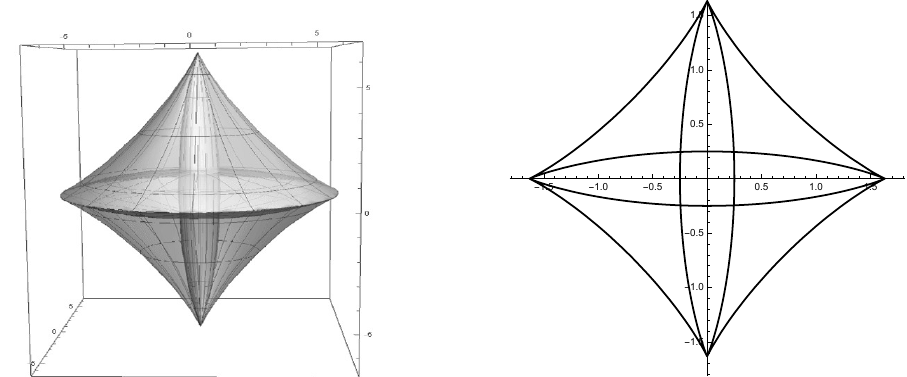
Figure 3. Left : The image ξ γ ( S 2 ) of the Cahn–Hoffman map ξ γ : S 2 → R 3 for γ : S 2 → R > 0 defined by Equation (6). Right : The section of ξ γ ( S 2 ) in the ( x 1 , x 3 ) -plane.